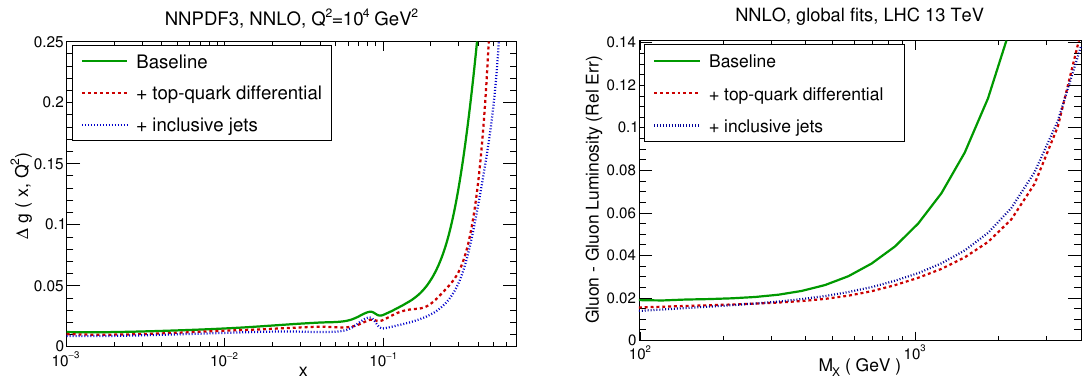
Figure 21 . The relative PDF uncertainty on the large- x gluon (left) and on the gluon-gluon lumi- nosity at large values of M X (right plot) in the global baseline (cid:12)t, compared with the corresponding (cid:12)ts including either top-quark pair di(cid:11)erential measurements or jet production